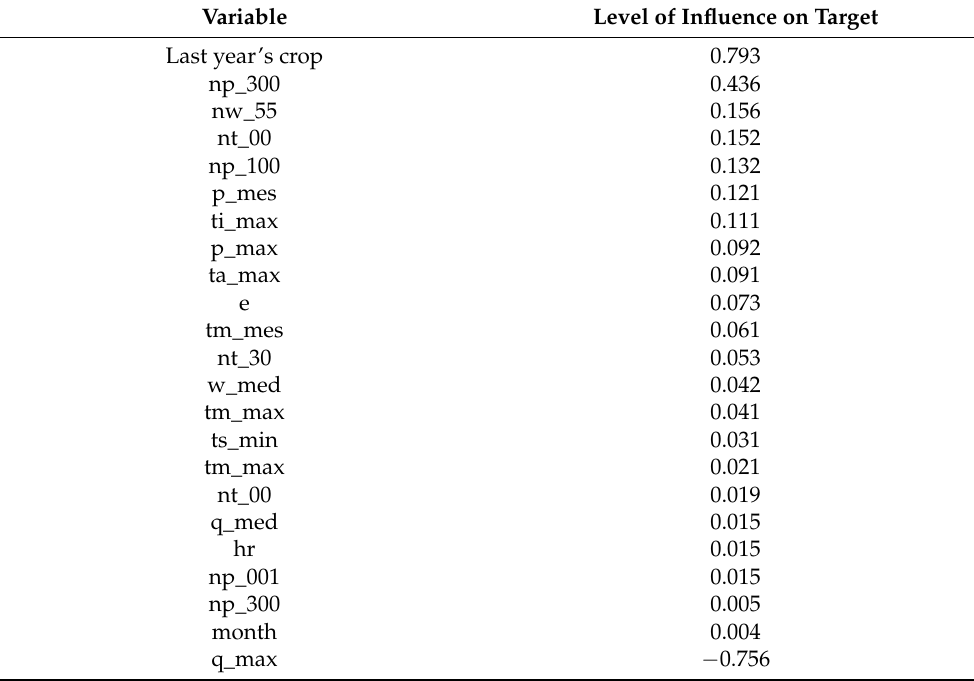
Table 4. Ranking and weight assigned to each